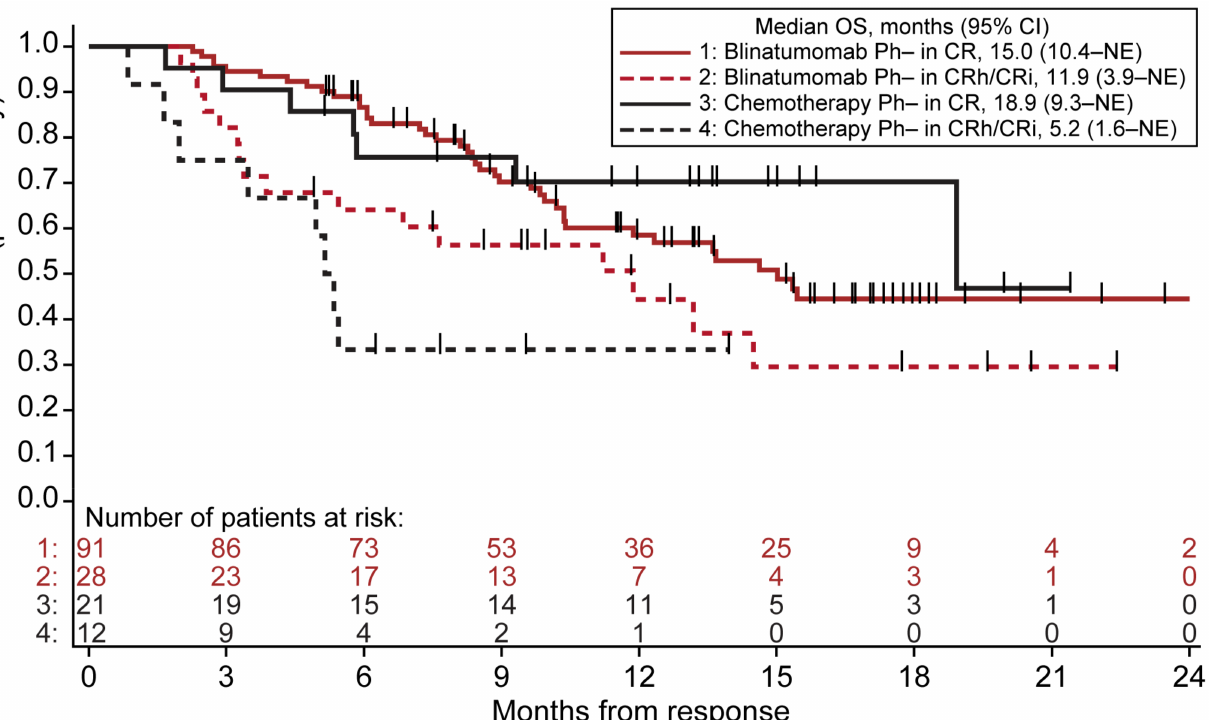
Figure 4. OS analyzed according to the response within 12 weeks of treatment with blinatumomab or chemotherapy in the patients with Ph − R/R BCP ALL. ALL, acute lymphoblastic leukemia; BCP, B-cell precursor; CI, confidence interval; CR, complete remission; CRh, CR with partial recovery of peripheral blood counts; CRi, CR with incomplete recovery of peripheral blood counts; NE, not estimable; OS, overall survival; Ph − , Philadelphia chromosome-negative; R/R,